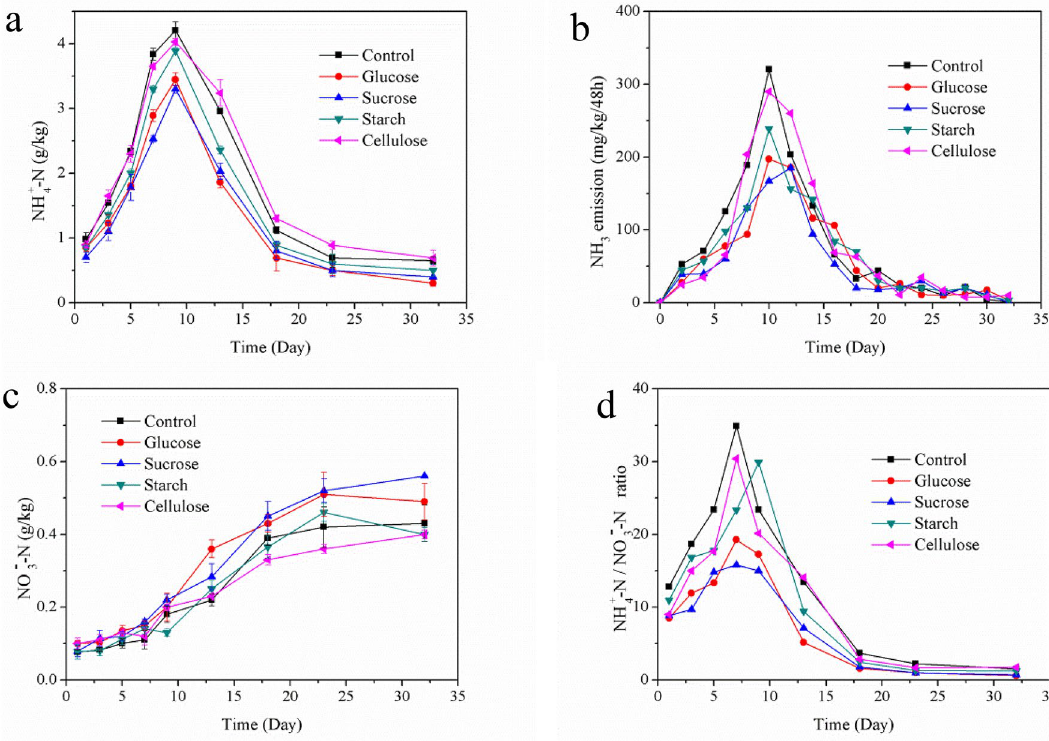
Figure 3. Evolution of NH 4 + -N ( a ), NH 3 emission ( b ), NO 3 – N ( c ) and NH 4 + -N/NO 3 – N ( d ) in five